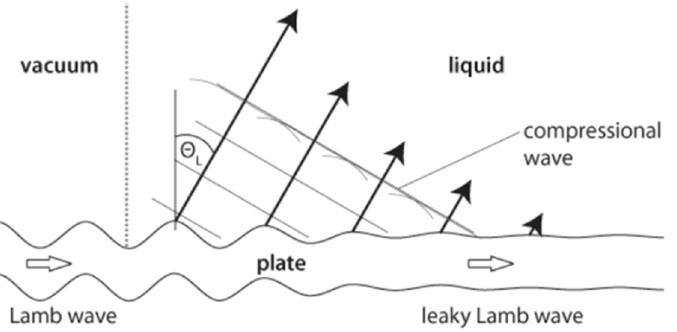
Figure 1. Generation of a compressional wave in the liquid by a leaky Lamb wave in the plate